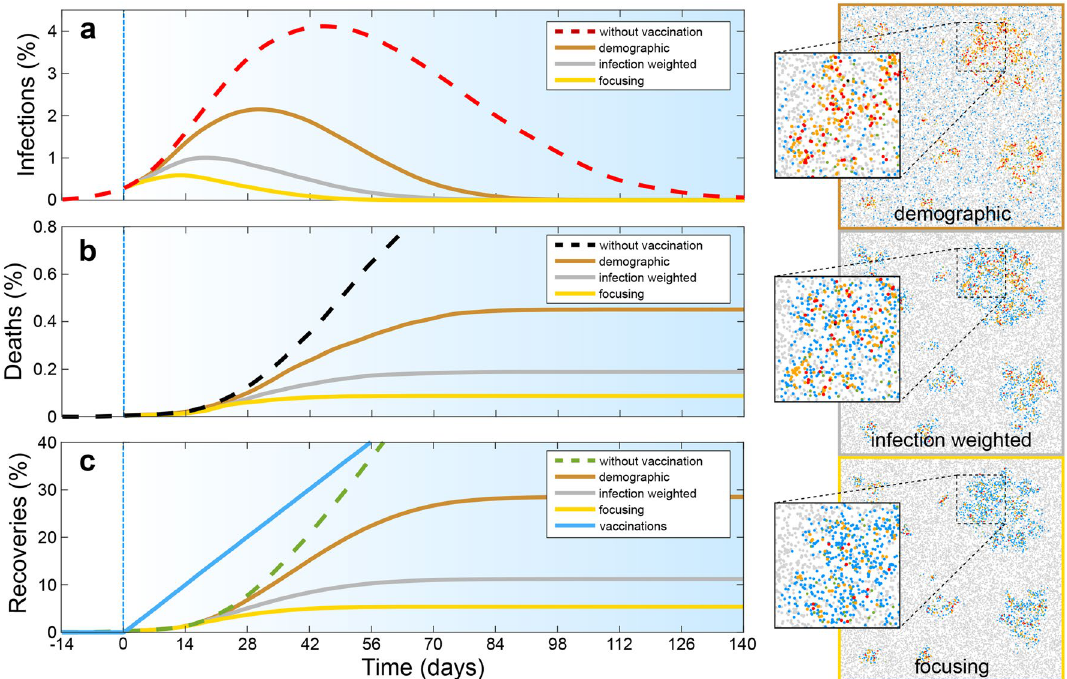
Figure 2. Competition of spatiotemporal vaccine distribution strategies regarding the time evolution of the fraction of infected individuals ( a ), the fraction of deaths ( b ), and of recoveries and vaccinations ( c ). Dashed red lines show simulation results without vaccination and bronze, silver (or grey) and gold show results for the demographic vaccine distribution strategy, the infection weighted strategy and the focusing strategy respectively. The blue line in panel ( c ) shows the vaccinated fraction of the population and vertical blue lines mark the onset of vaccination; the specific time of which is unimportant (see text). Panels on the right show simulation snapshots taken 14 days after the onset of vaccine production; insets magnify extracts of these snapshots. t D / 3 , survival probability s r 14 days ; latency time t L 0.965, s o 0.99 , Parameters: Disease duration t D = = = = 2.5 . (The latter is based on 0.1 N / t D and initial reproduction number R 0 total vaccination rate ν = = D 500 R c ; curves are averaged over 100 random initial 0.3 , β r 0.1 ; see “Methods”); L 10 2 R 2 c / t D , β o = = = = 6000 ensembles with N =